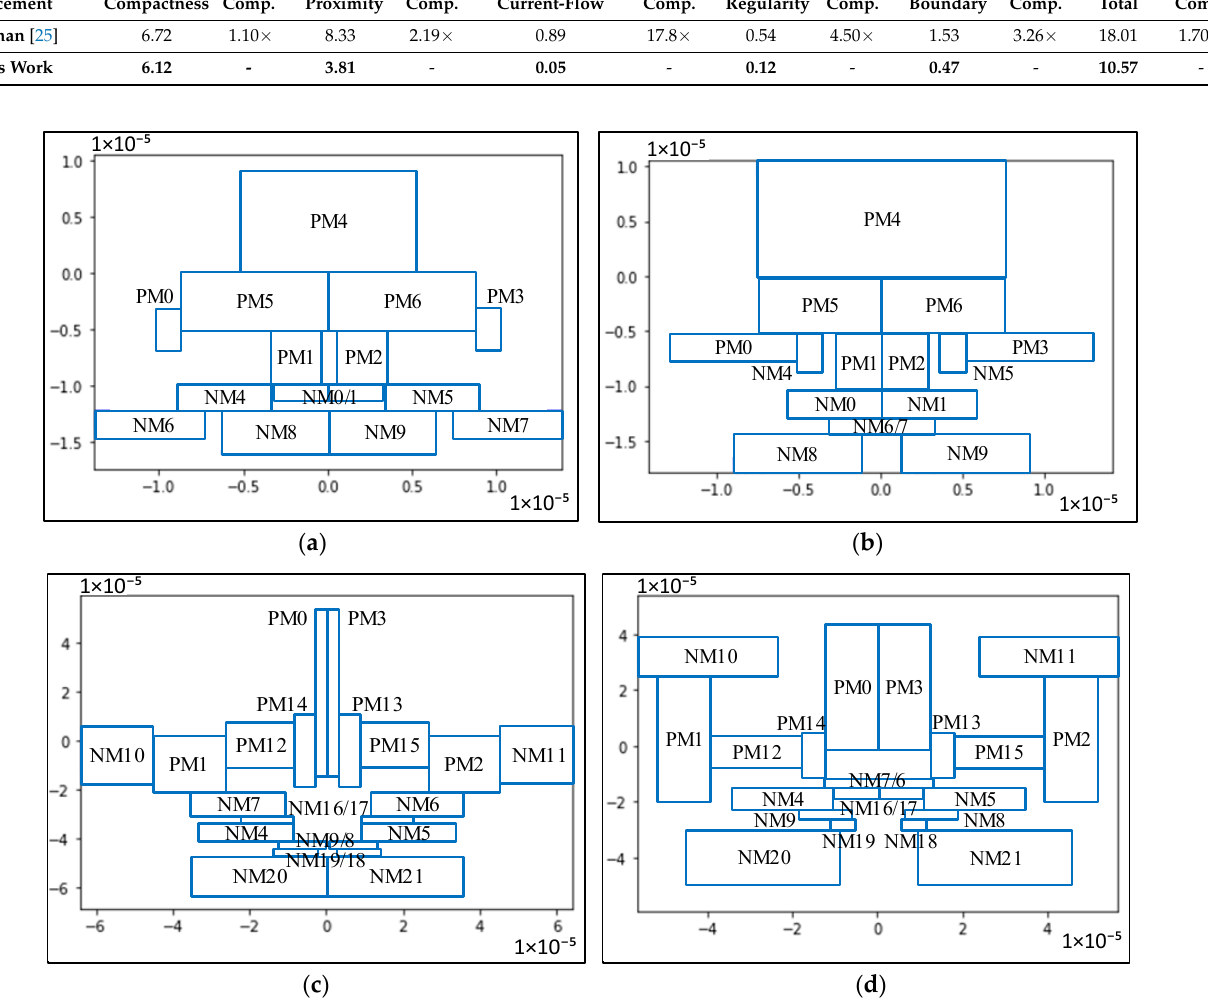
Table 5. Comparison of the automatically produced and human-designed floorplan solutions. Compactness Comp.